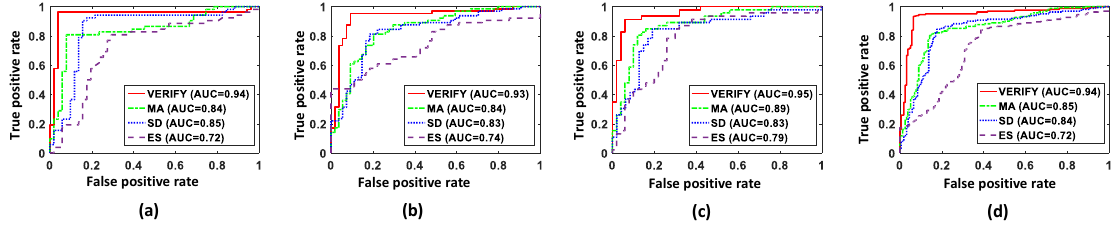
Figure 7. Receiver Operating Characteristic (ROC) curves and Area Under the Curve (AUC) values for: ( a ) subcompact vehicles; ( b ) mid-sized vehicles; ( c ) full-sized vehicles; and ( d ) all vehicles. According to [9,11,16], MA, SD and ES achieved the accuracies of 98%, 90% and 91% for vehicle entrance classification, respectively, and 99%, 100% and 95% for front/rear classification,